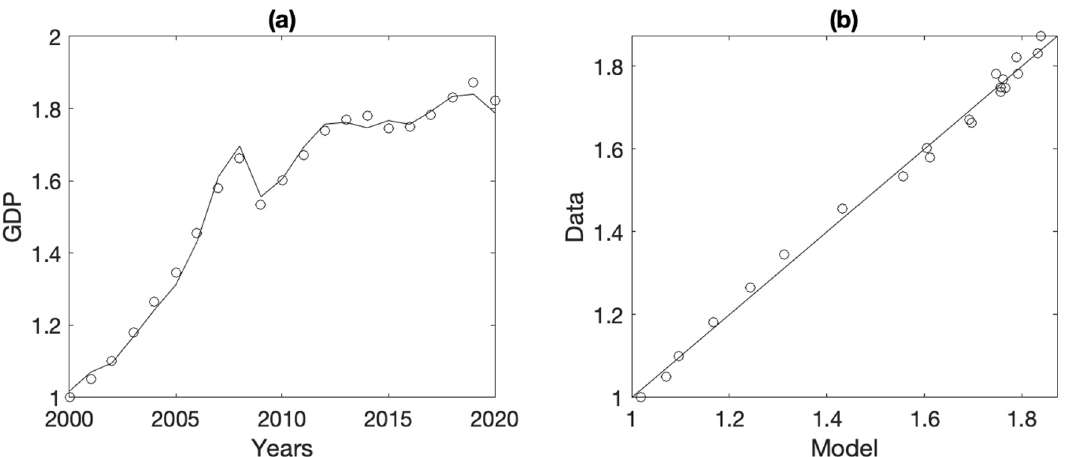
Figure 3. Dynamics of the GDP physical volume index ( a ) and actual data and model values ( b ). Circles denote actual data, black line is values obtained according to the Cobb-Douglas PF (1) with parameters from Table 1, where IFA is taken as the capital C .